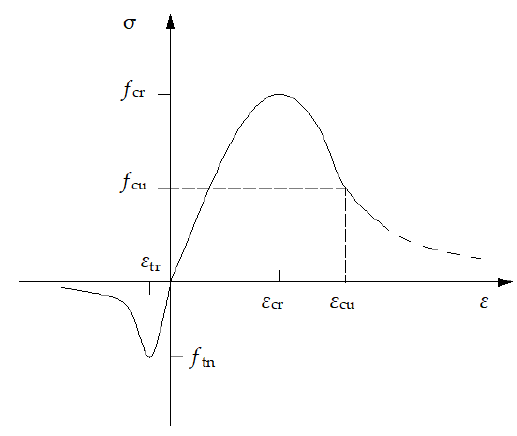
Figure 10. The stress–strain relationship of concrete.